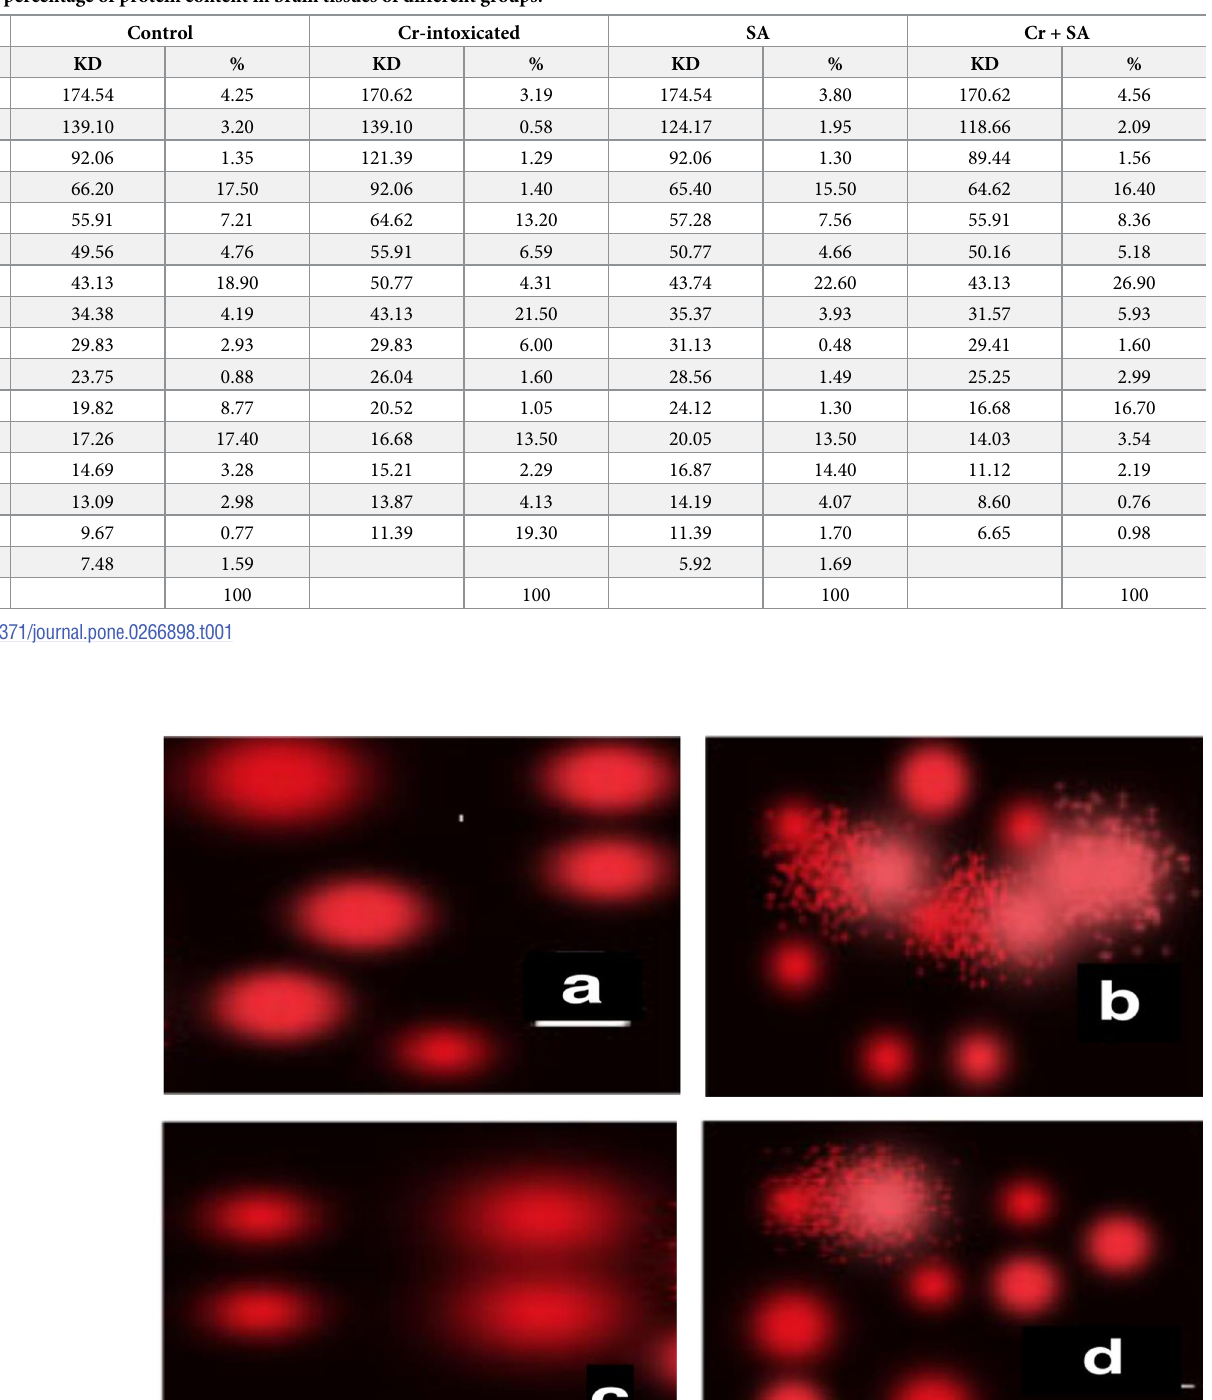
PLOS ONE | https://doi.org/10.1371/journal.pone.0266898 April 14,